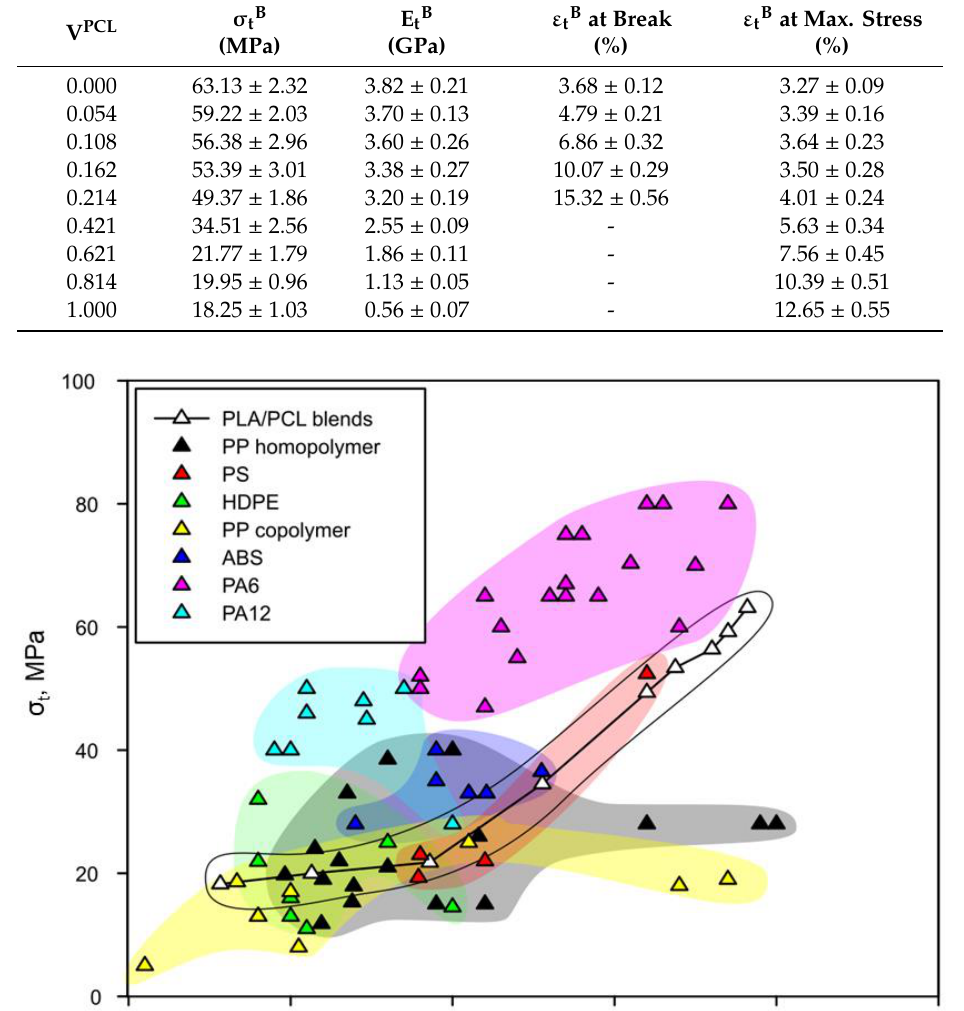
Table 2. Tensile strength, Young’s modulus and strains at break and at maximum stress of the PLA / PCL blends.